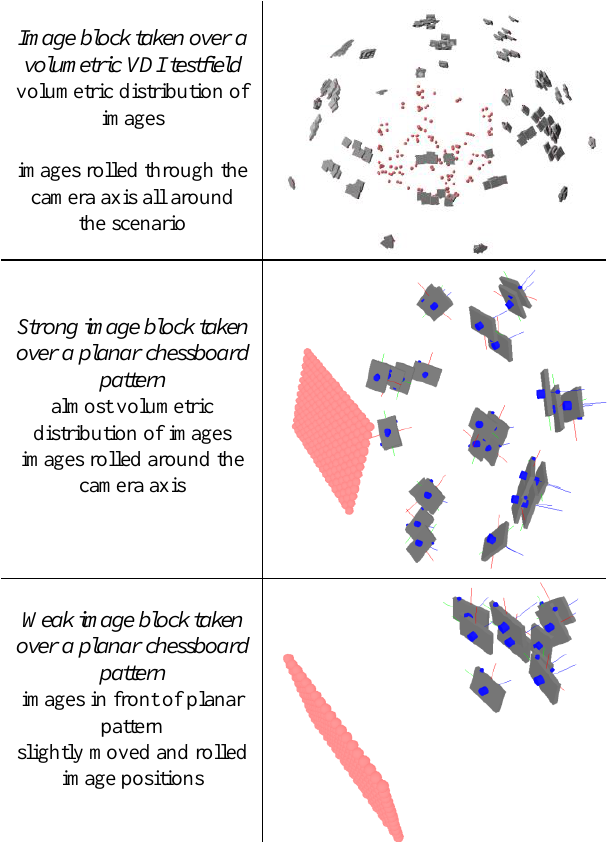
Table 2. Image block configurations for camera